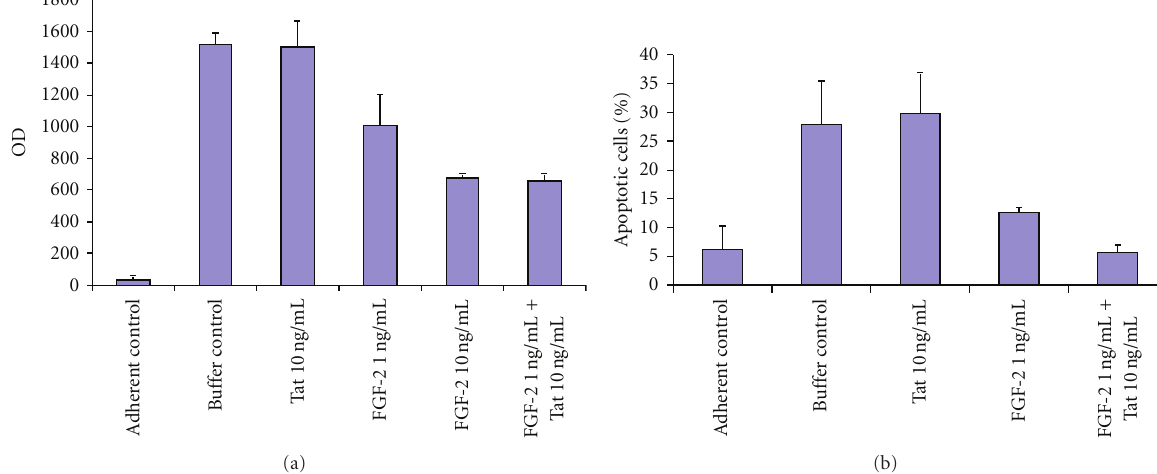
Figure 3: E ff ect of FGF-2 and Tat on human endothelial cell anoikis . HUVECs were seeded onto poly- (HEMA)-coated plates and incubated for 6 h with FGF-2 (1 or 10 ng/mL) and/or Tat (10ng/mL), controlled by their dilution bu ff er (PBS-0.1% BSA). HUVECs plated onto gelatin were the negative control for apoptosis. In (a) are the results from the ELISA test determining the amount of nucleosomes in HUVECs cytoplasm. The mean OD readings from 4 independent experiments (+SD) are presented. In (b) HUVECs apoptosis was evaluated by TUNEL test. The mean percentage (+SD) of apoptotic cells was determined from 4 high-power fields (40X magnification) of 3 independent